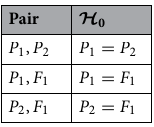
Table 2. Formal hypotheses definitions for pairs of cross